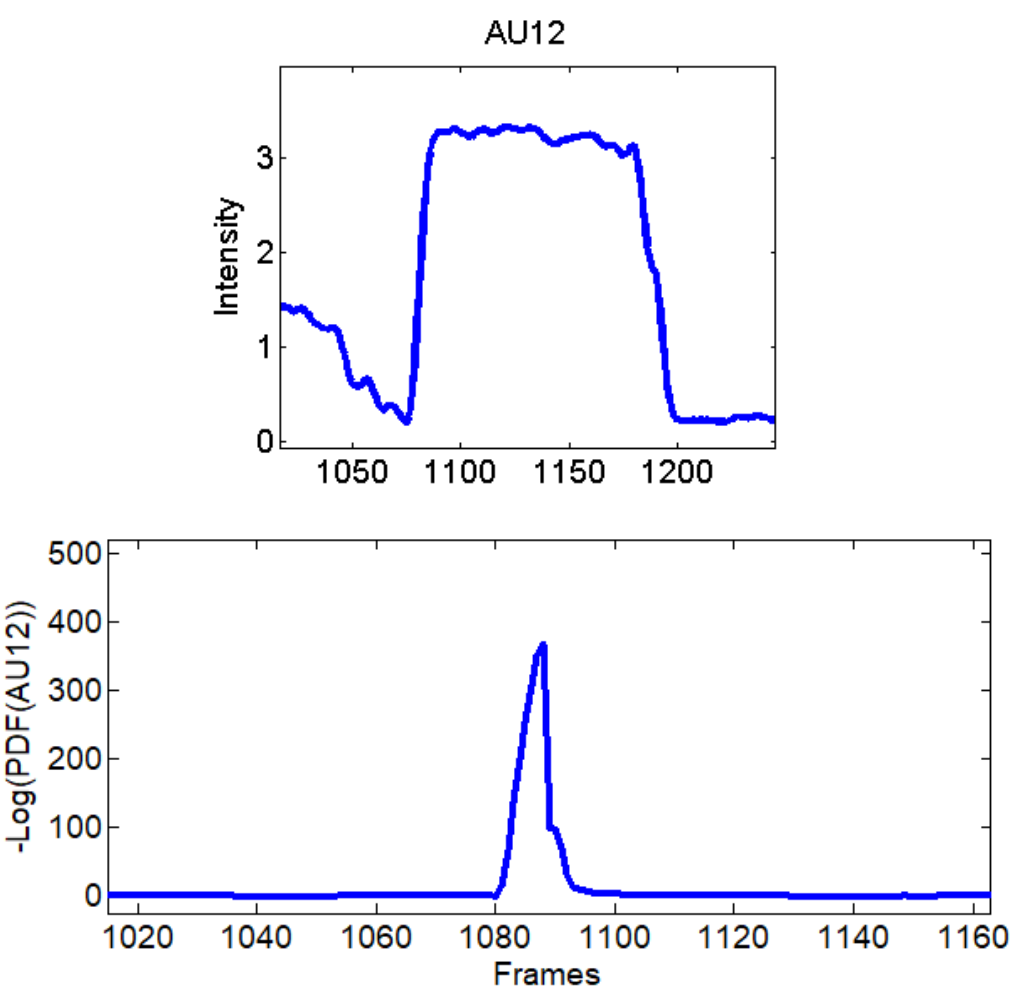
Figure 4. ( Top ) Intensity of AU12 while lip corners were pulled up; and ( Bottom ) corresponding computed